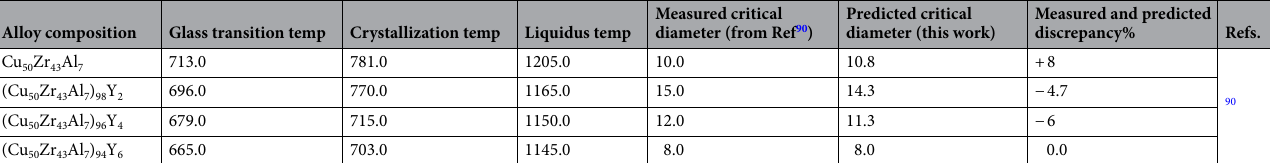
Table 2. Experimental validation of ML model using the four different alloys.